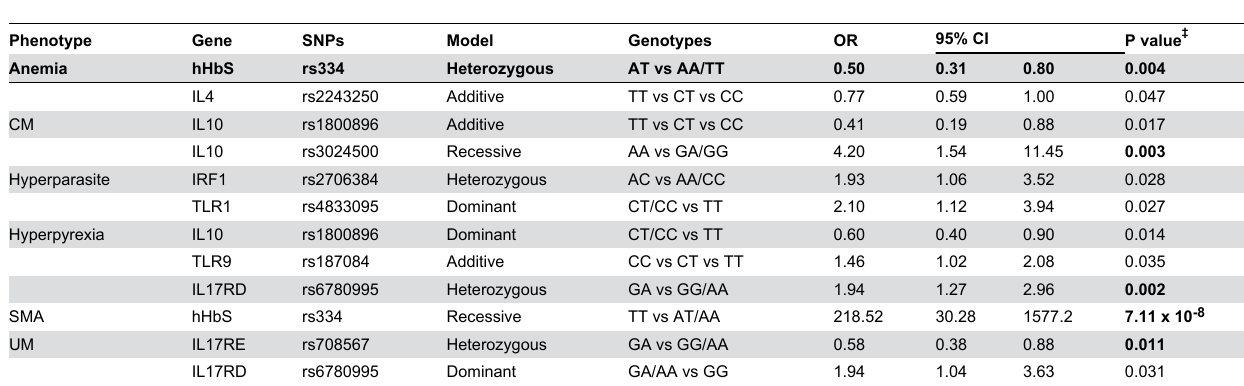
Table 4. Results of genotype associations between selected SNP and syndromes of